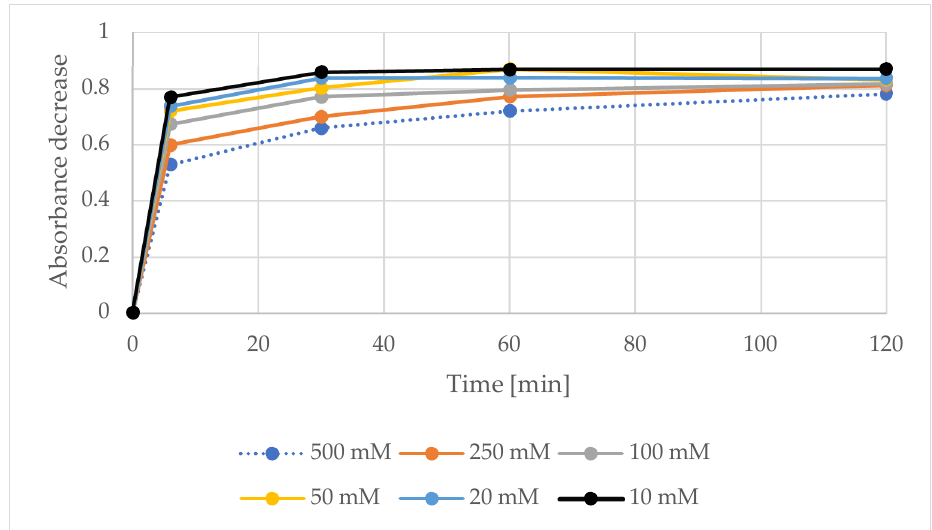
Figure 7. Effect of ionic strength on the reaction of ABTS • with human blood plasma. Decrease of